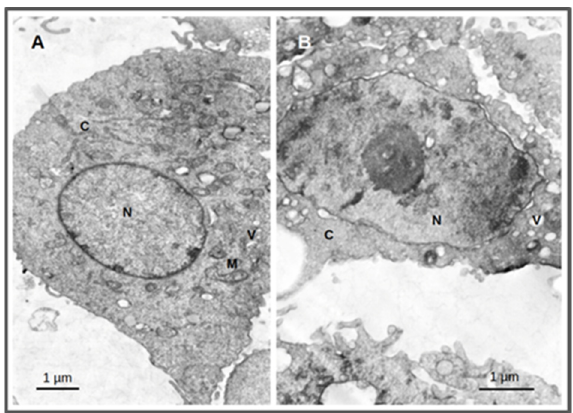
Figure 10. Thin-section transmission electron microscopy images of PC3 cells treated for 4 h with AuNP-BBN at a concentration of 36 µg Au/mL followed by irradiation with 2 Gy (1 Gy/min). Samples were analyzed and photographed in a JEOL 1200-EX electron microscope. Irradiated PC3 cells ( A ); irradiated PC3 cells after incubation with AuNP-BBN. ( B ); N = nucleus; C = cytoplasm; M = mitochondria; V = vacuoles. Bars = 1 micrometer.